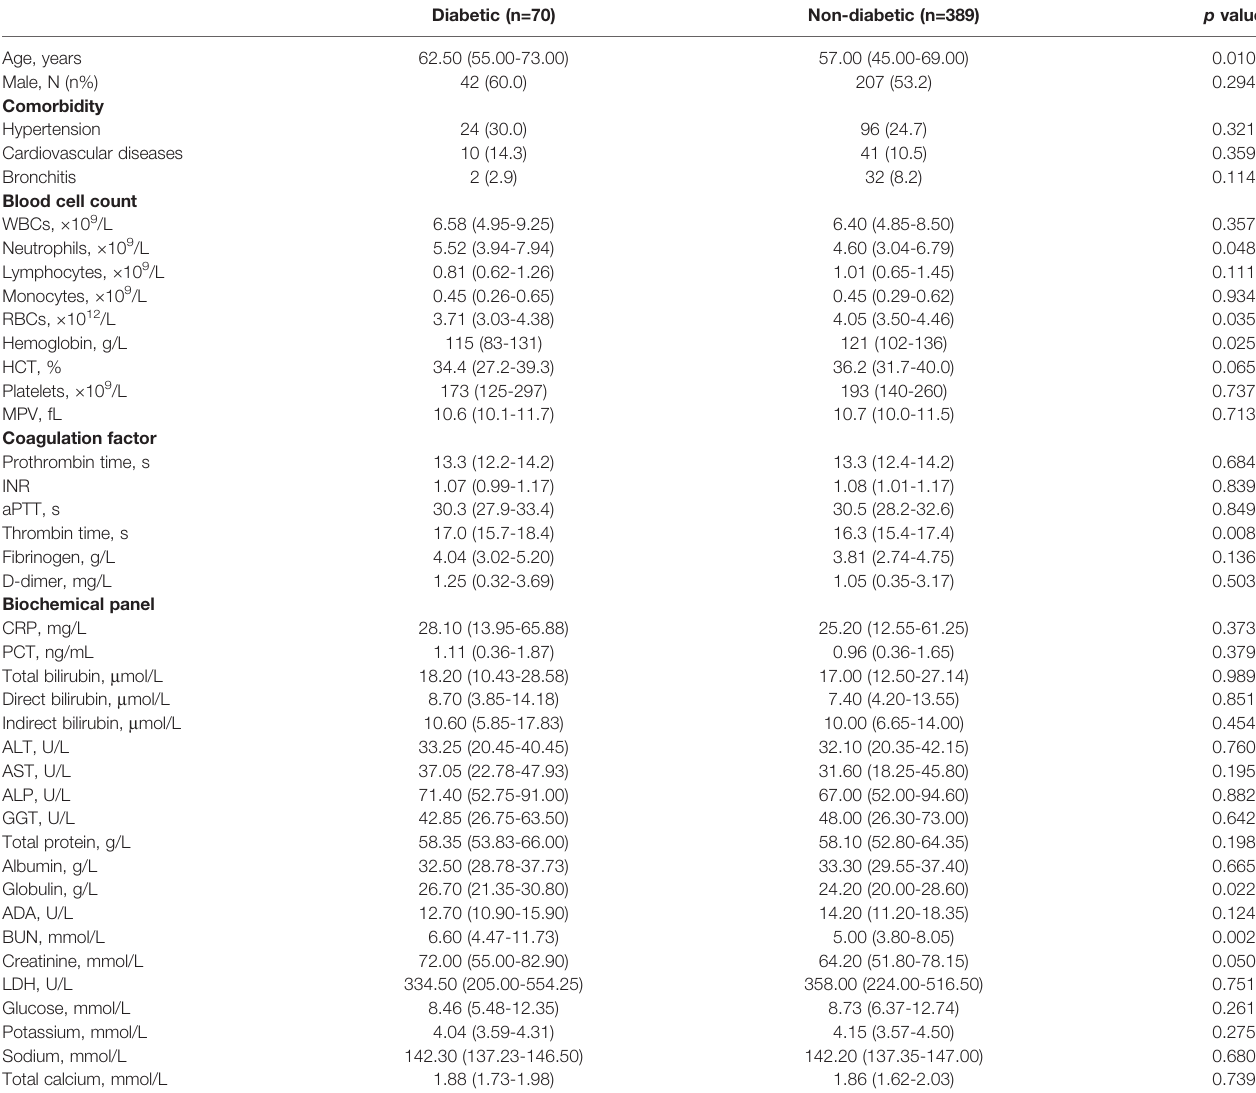
TABLE 1 | Comparison of clinical characteristics between diabetic and non-diabetic groups infected by SARS-CoV-2 in 2020. Diabetic